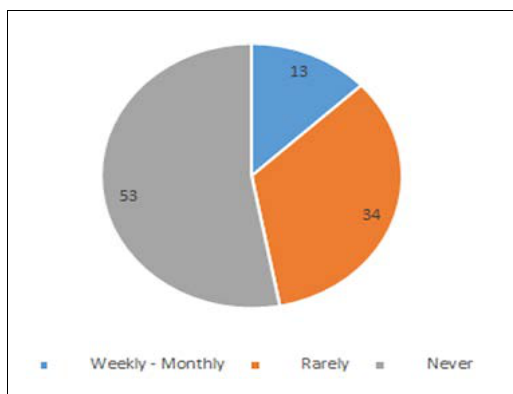
Figure 2: Frequency of students attending an offline activity within their